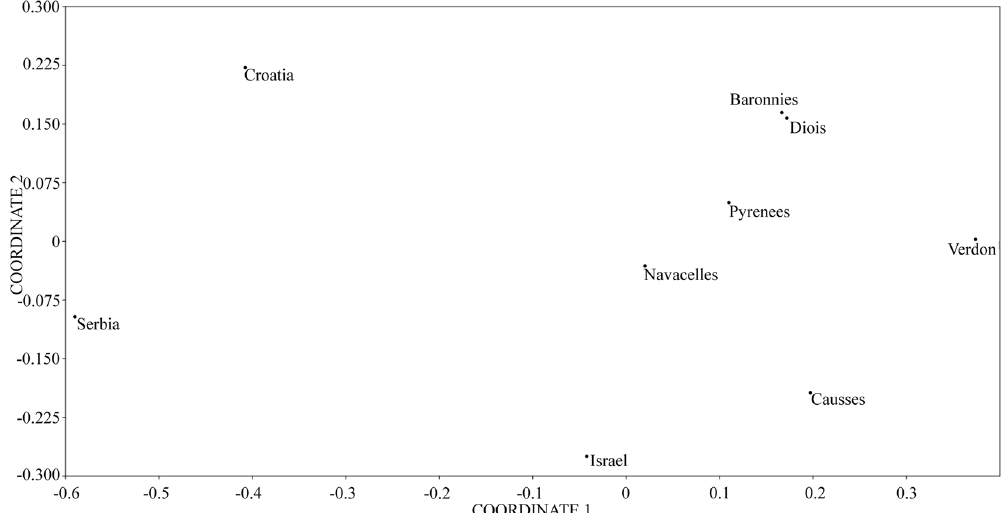
Figure 1. Non-metric multidimensional scaling plot of F ST distances between the G. fulvus population of Serbia and other native and introduced G. fulvus populations based on the analysis of 10 microsatellite loci. The goodness of fit is expressed with the stress value which is 0.1644 for this data set. Population pairwise F ST values are presented in Table